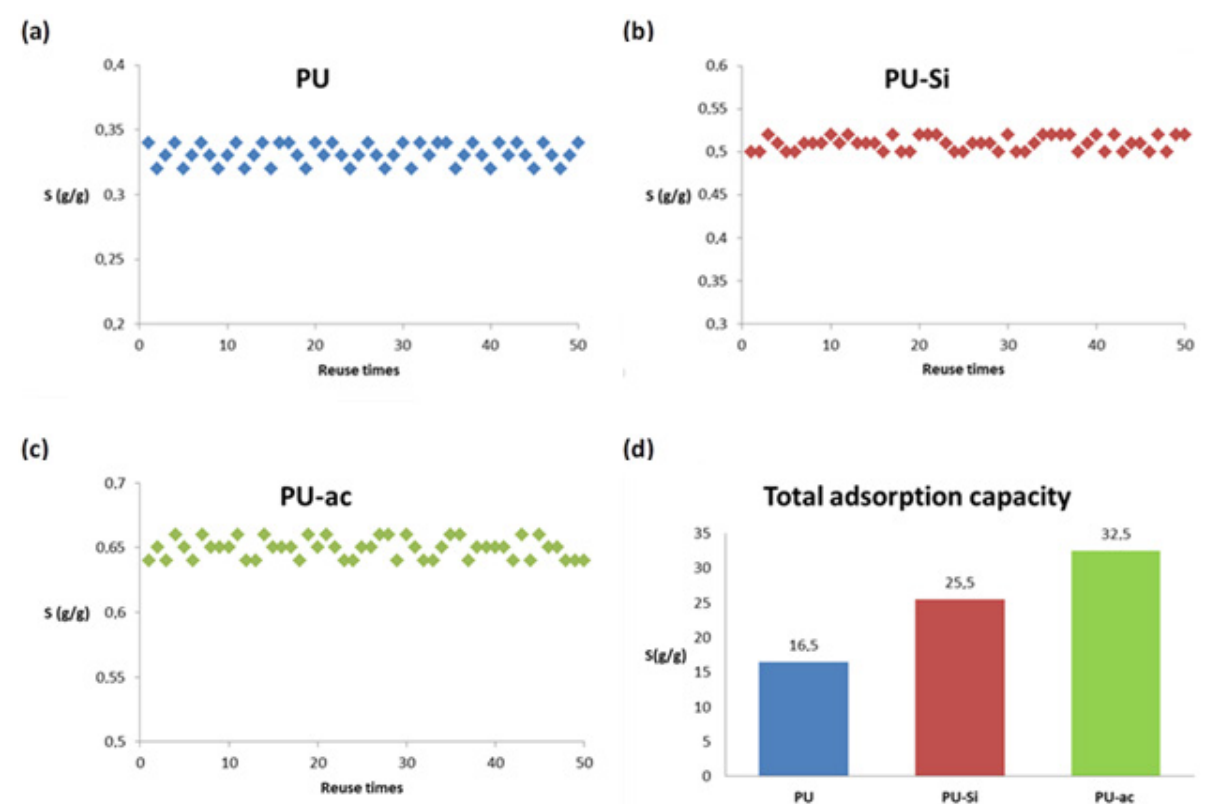
Figure 4. ( a ) Reuse of polyurethane PU 1 in diesel after 50 regeneration cycles. ( b ) Reuse of polyurethane composite PU-Si 2 in diesel after 50 regeneration cycles. ( c ) Reuse of polyurethane composite PU-ac 3 in diesel after 50 regeneration cycles. ( d ) Total adsorption capacity for the three types of tested materials.